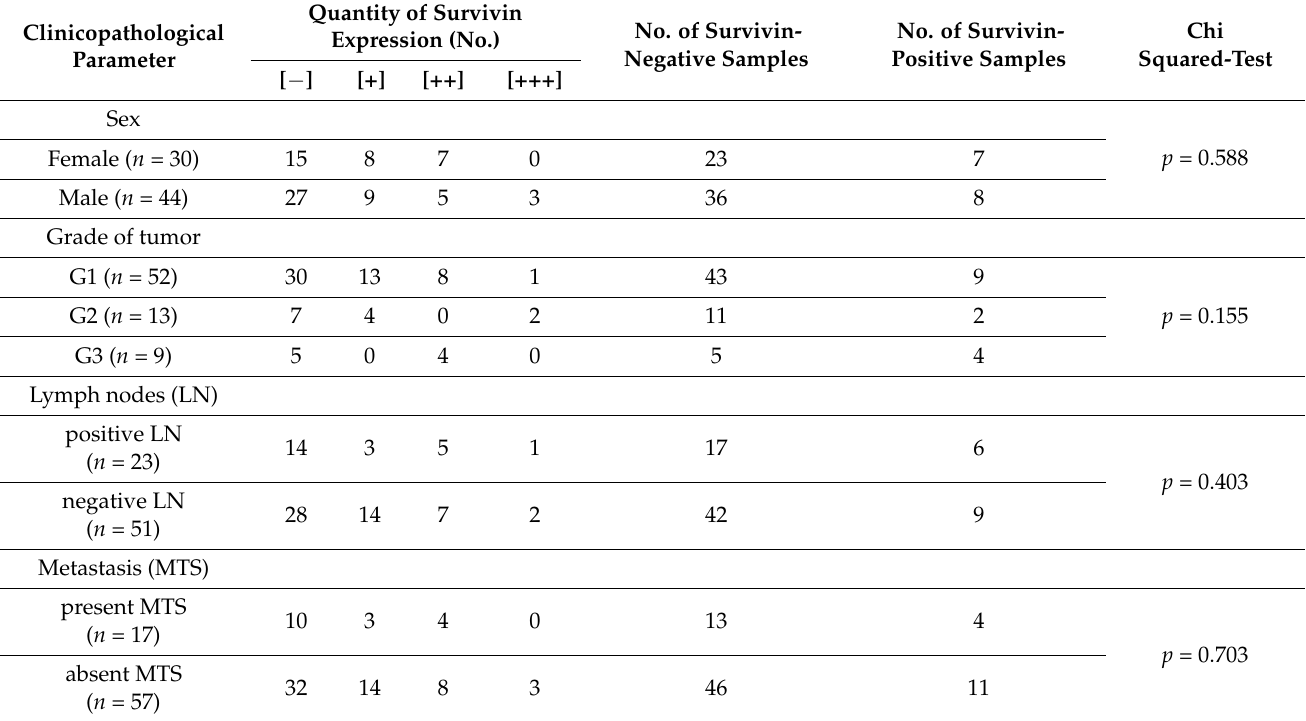
Table 4. Statistical evaluation of survivin expression in comparison to clinicopathological parameters (sex of patients, grade of tumor, nodal status and absence/presence of